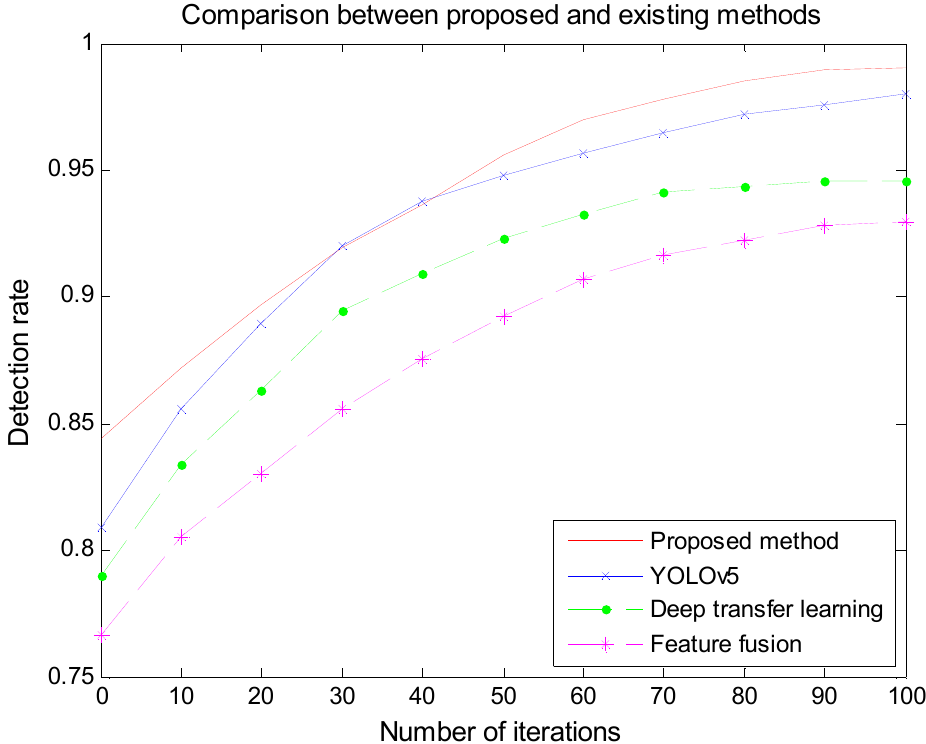
Figure 15. Safety belt detection.